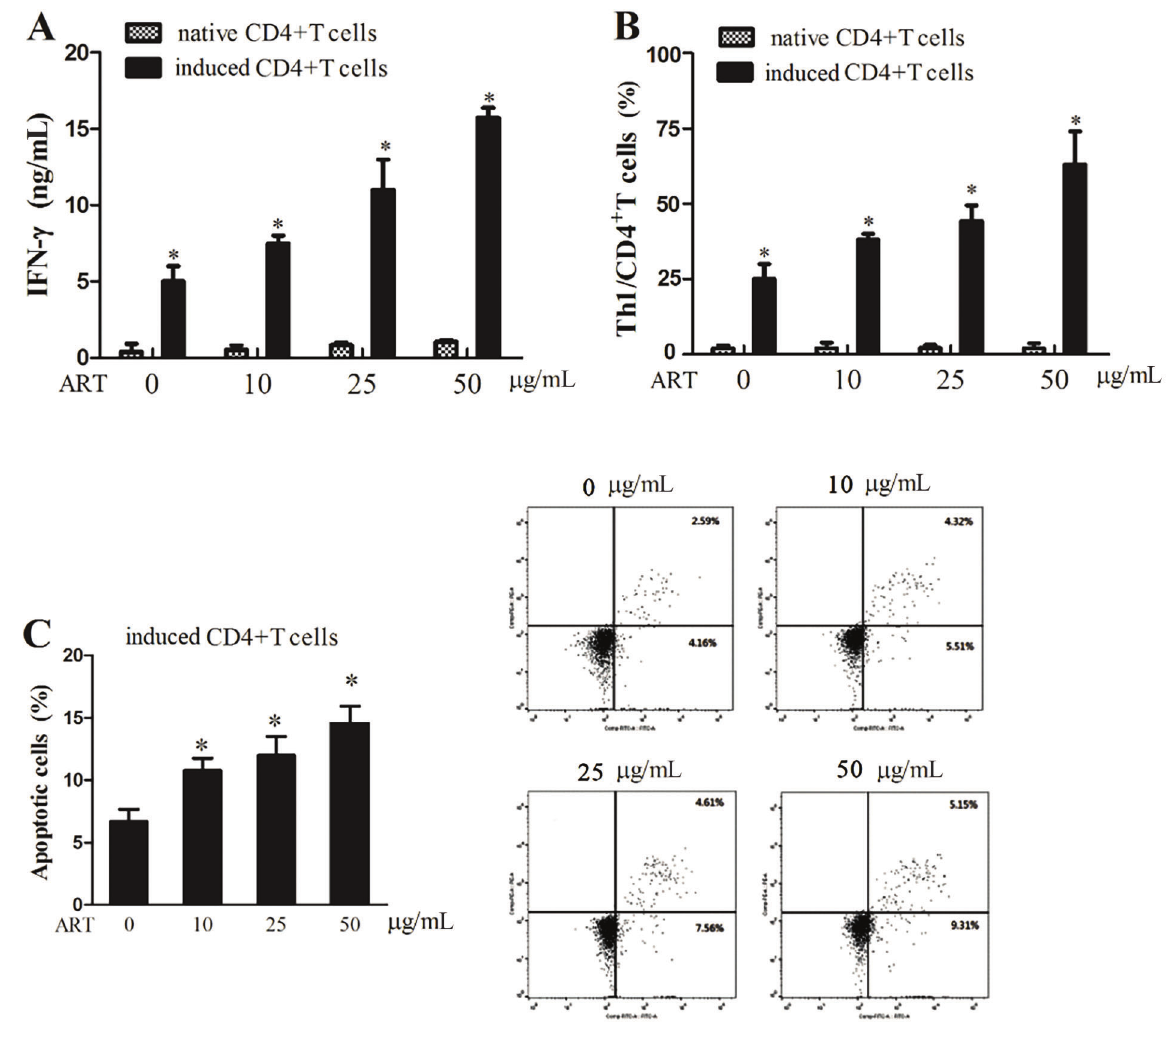
Figure 2. Artesunate (ART) promoted cell apoptosis of ovarian cancer through inducing Th1 differentiation. A , Interferon (IFN)- g level in culture supernatant was examined by enzyme linked immunosorbent assay. B, Percentage of Th1/CD4 + T cells was analyzed using fl ow cytometry. C , After co-cultured with the differentiation-induced and artesunate-treated CD4 + Tcells, ID8 cells apoptosis was measured using fl ow cytometry. Data are reported as means ± SD. *P o 0.05 compared to native CD4 + T cells (A and B) and to 0% ART (ANOVA).